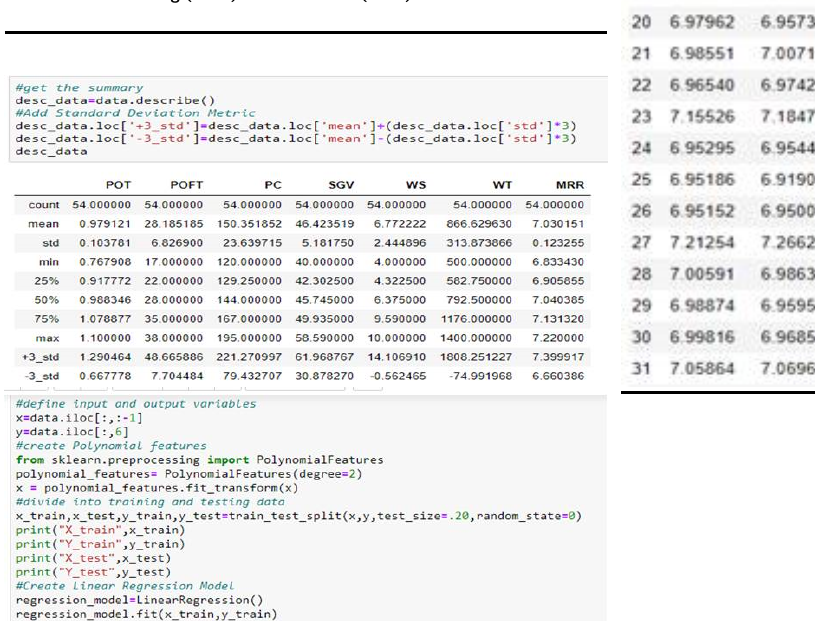
Table 7: Instructions to preprocess the MRR dataset and split the dataset into training (80%) and test data (20%).